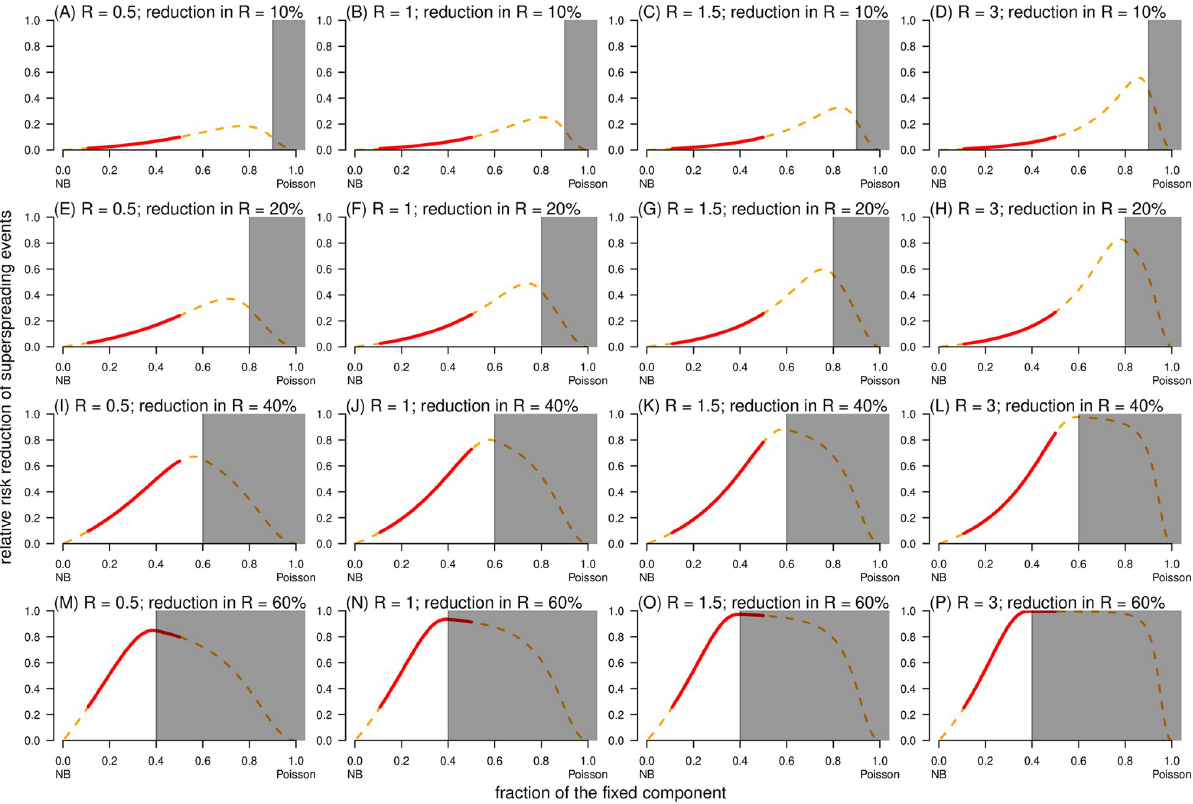
Fig 8. The relative risk reduction, RRR (2,1) ( ξ ), of outcome (I): Having superspreading event under control scheme (II) against scheme (I) as a function of the fraction of fixed component ( ρ ). In each panel, the dispersion parameter k is fixed at 0.2, the shading region indicates the situation that ξ � 1 − ρ , and the bold red segment highlights the range of ρ from 0.1 to 0.5, which characterizes the feature of COVID-19. In each panel label, ‘ R ’ is the reproduction number, and ‘reduction in R ’ is the relative reduction in reproduction number ( ξ ). The ‘NB’ in the horizontal axis label stand = s for negative binomial